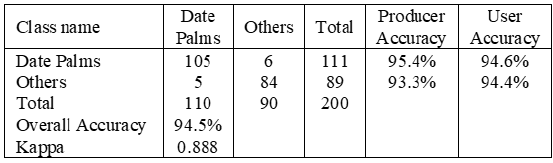
Table 5. Accuracy assessment of mapping the date palms using OOC on WV-2